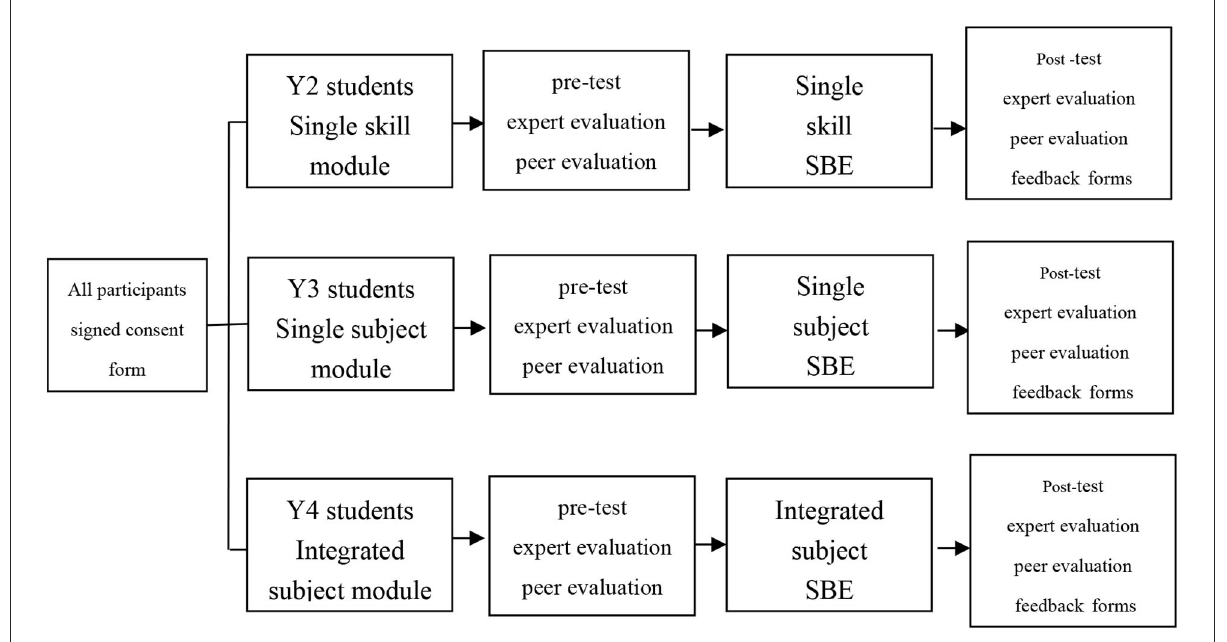
FIGURE1 The general flowchart of the whole research. SBE, simulation-based